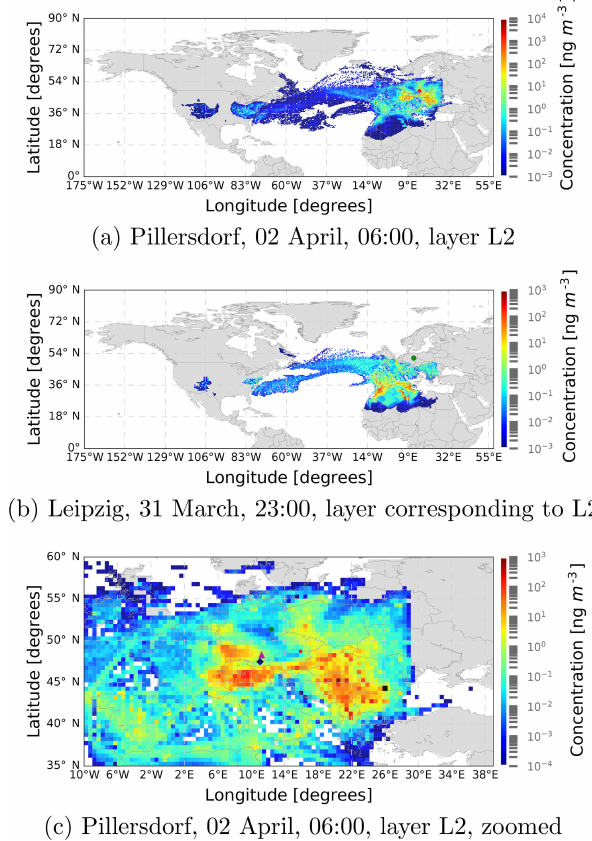
Figure 11. Relative distributions of SO 2 sources for Pillersdorf layer L2 (a) , Leipzig (b) ; zoomed distribution for Pillersdorf layer L2 (c)